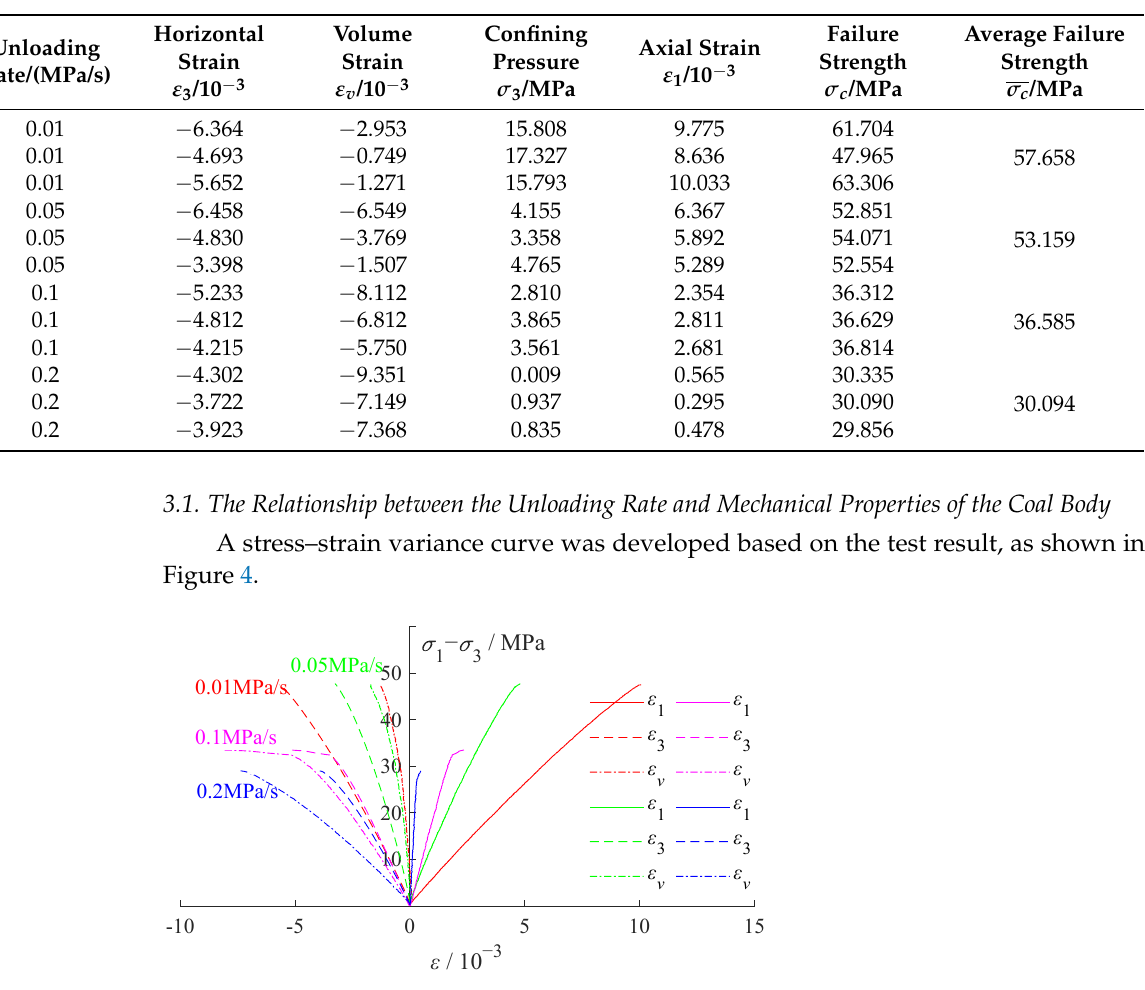
Figure 4. The stress–strain variance curve.